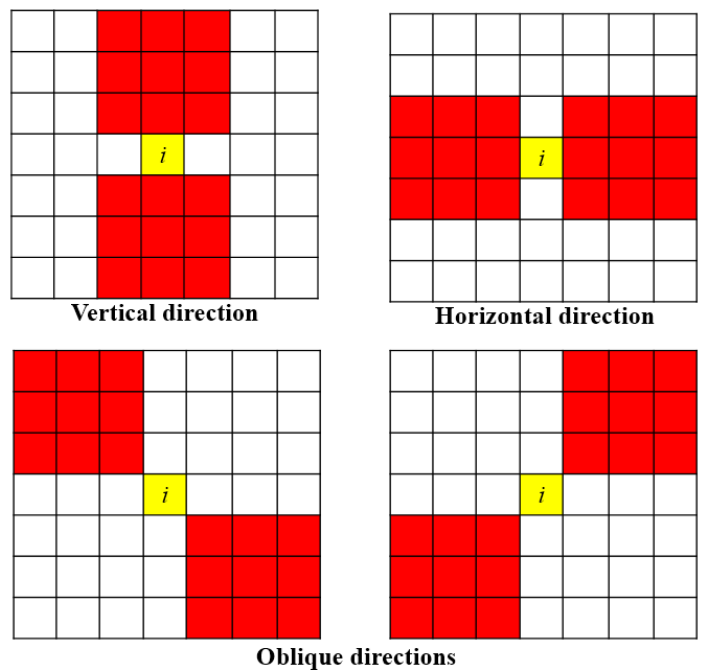
Figure 1. The gradient directions used in the RGPI.